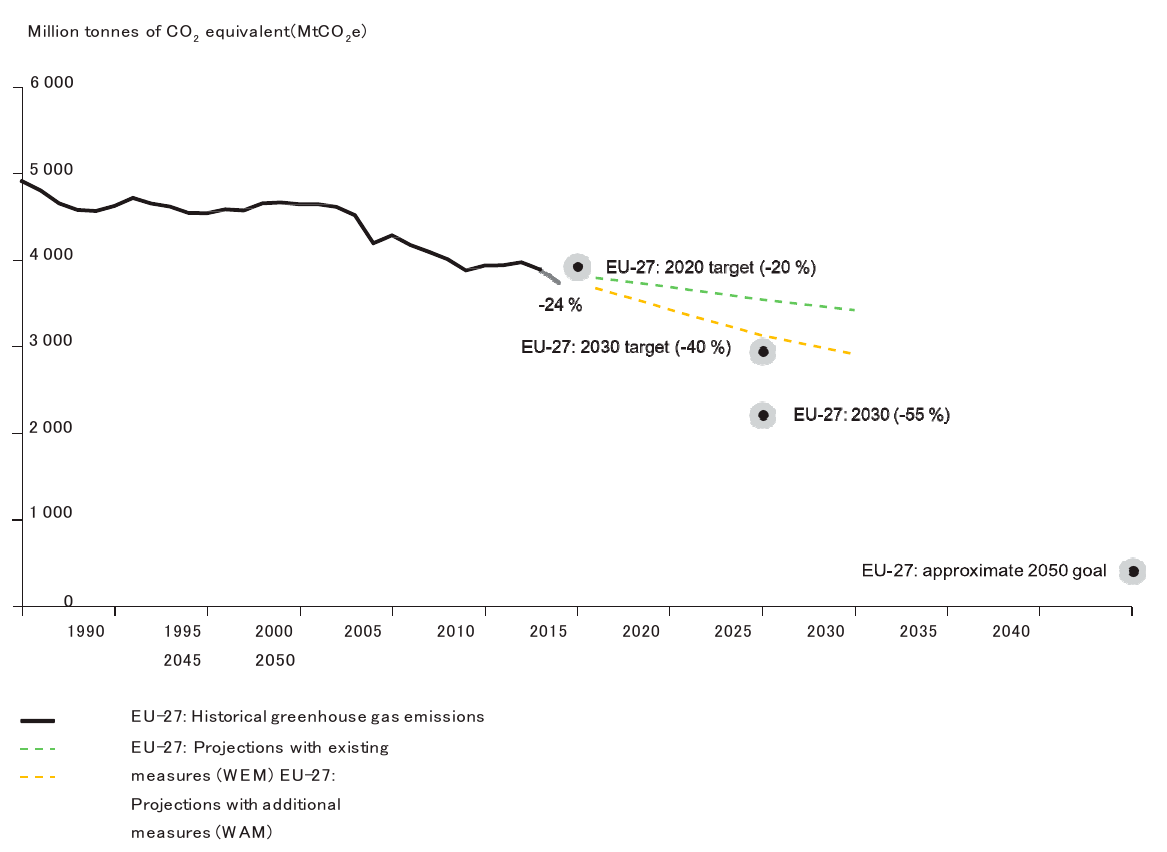
Figure 19. Greenhouse gas emission targets, trends and Member States’ MMR projections in the EU, 1990–2050, European Environmental Agency [212].